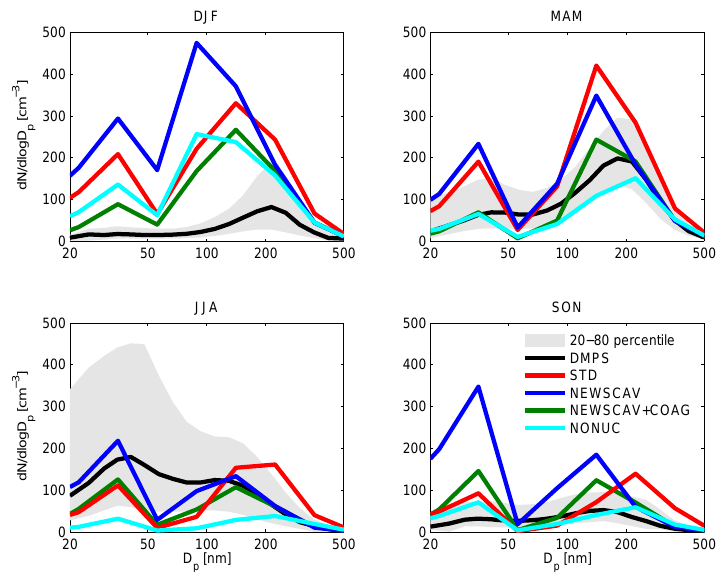
Figure 4. Seasonal-median number distributions from DMPS measurements at Mt. Zeppelin (2011–2013) and for the GEOS-Chem-TOMAS dry size distribution simulations (described in Table 1). The measurement 20–80th percentile is in grey shading. Simulations are shown in colour as indicated by